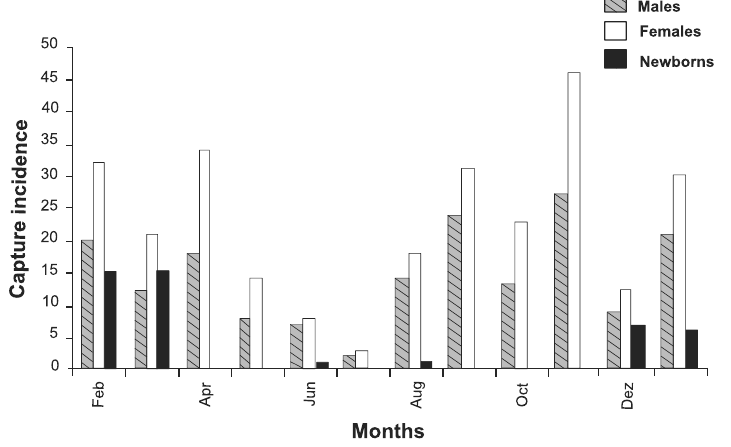
Fig. 3 – Accumulated capture incidence in an altered grassy field, municipality of Santa Maria (Rio Grande do Sul state, Brazil), from February 2001 to January 2004. The black bars indicate newborns, incomplete bars indicate females, and striped bars indicate